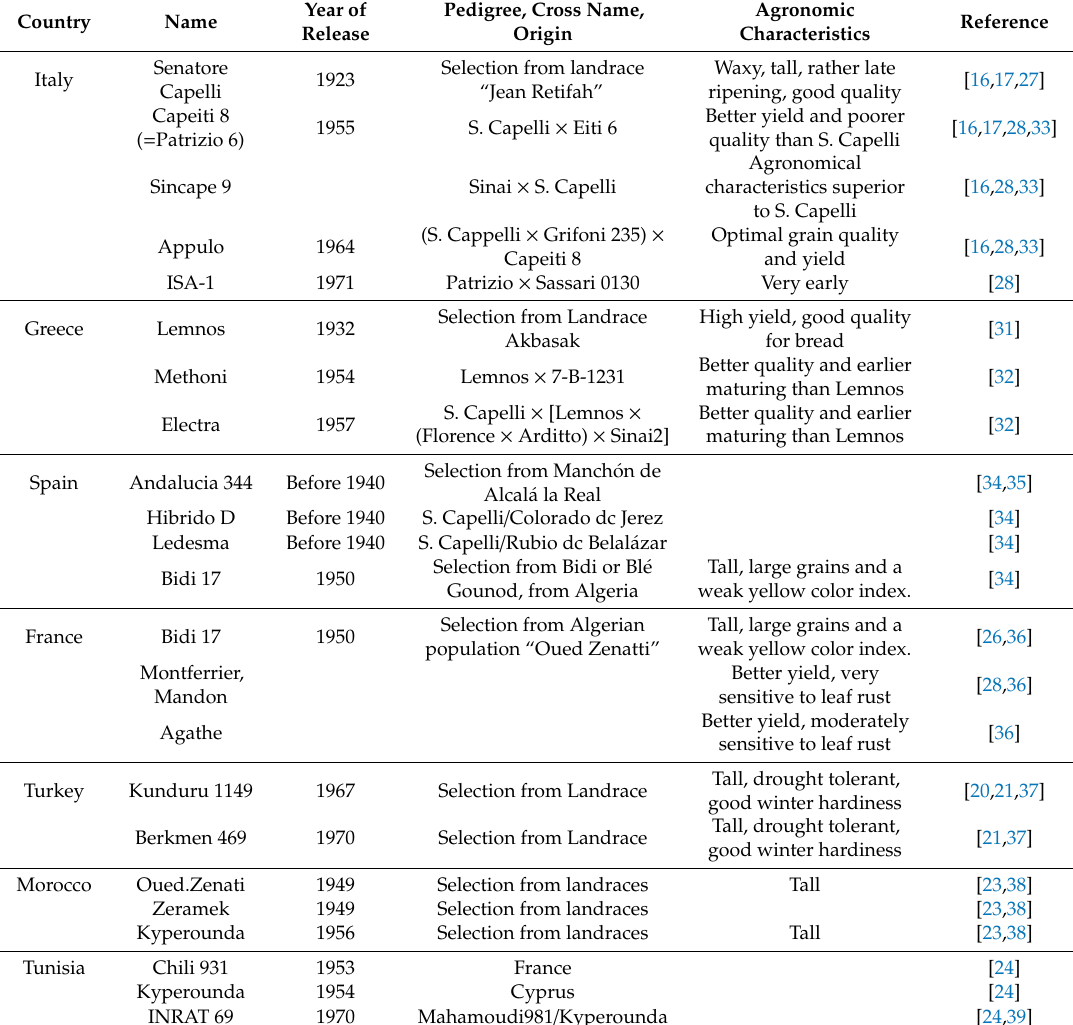
Table 3. The main Mediterranean cultivars released before the Green